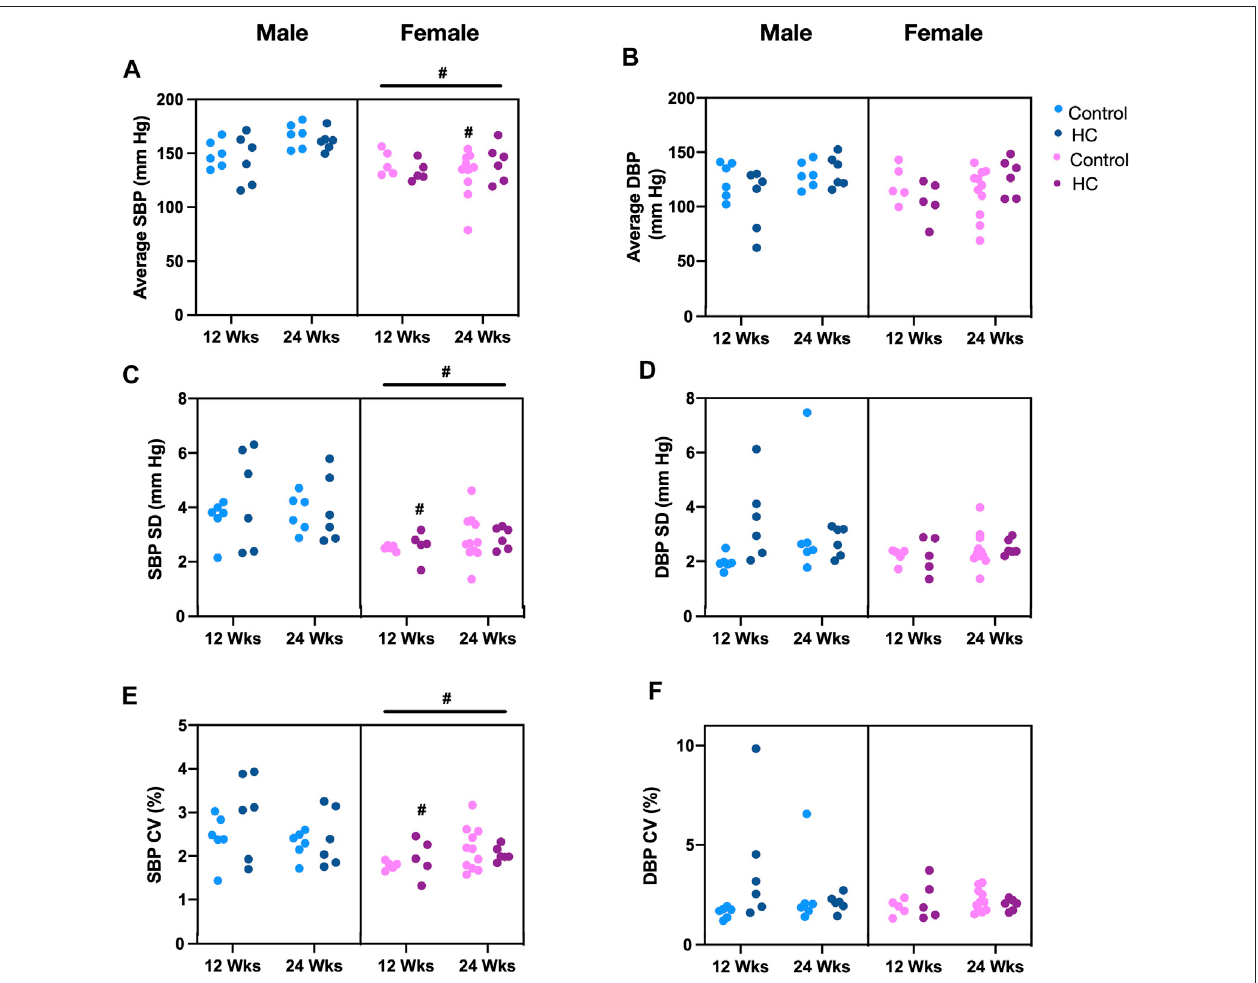
FIGURE 5 | Impact of HC-feeding on average and linear parameters of beat-to-beat systolic and diastolic blood pressure (SBP and DBP, respectively) in rats of either sex in different feeding duration groups. (A,B) Average, (C,D) standard deviation (SD), and (E,F) coef fi cient of variation (CV) of SBP and DBP, respectively, in control and HC-fed rats of either sex in different feeding duration groups. Statistical analysis was performed by three-way ANOVA followed by Sidak ’ s multiple comparisons test. * denotes a p < 0.05 vs. control of the same feeding duration and sex (control vs. HC), while # denotes a p < 0.05 vs. the corresponding male group (males vs. females).